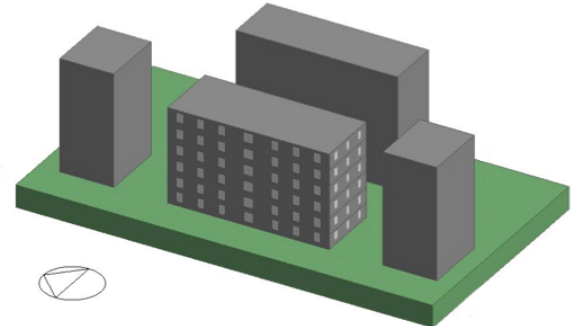
Figure 2. Building model and neighbouring build- ings in the graphical user interface. Orientation is specified on the lower